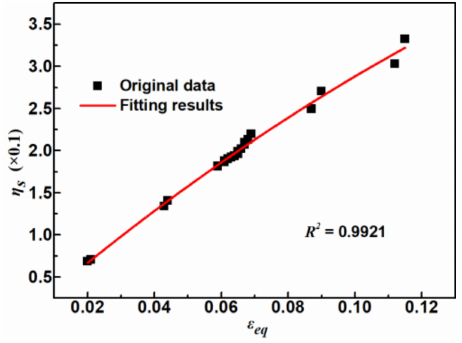
Figure 22. Comparison between the predicted and the fitting results for η s and ε eq